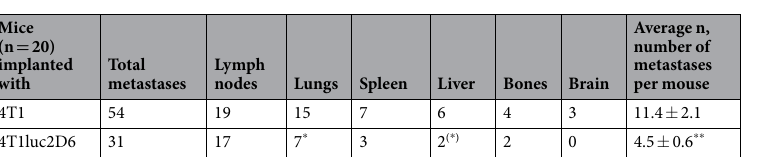
Fig. 7A,B). Luc-specific IFN- γ response was detected in both 4T1luc2D6- and in 4T1luc2-, but not in naïve, or 4T1-implanted mice (Fig. 7A). We followed the development of this response in mice implanted with 4T1luc2 cells in time. Lymphocytes were collected prior to and post 4T1luc2 implantation on days 6, 9 (PBMCs) and 23 (splenocytes), and stimulated with LucP. A weak LucP-specific production of IFN- γ first detected on day 9 post implantation, increased to significant levels by day 23 (Fig. 7B). Interestingly, induction of the response coincided with a decrease in the growth rate of the primary focus formed by 4T1luc2 cells (Fig. 2A). Immune response against luciferase induced by DNA immunization protects against the estab - lishment of 4T1luc2 tumors. To further test whether a Luc-specific immune response can limit tumor invasiveness, we primed and then boosted mice with a plasmid (pVaxLuc, dubbed Luc DNA) encoding the same variant of firefly luciferase as is expressed by 4T1luc2 and 4T1lucD6 cells. Control mice received an empty vector (pVax1). Plasmids were delivered by intradermal injections. Immediately after, mice were electroporated over the injection sites using DermaVax (Cellectis) generating driving pulses of 100 V (as described) 22 (n = 4) or CUY21 EditII (BEX Ltd.) generating driving pulses of 100 V (n = 6), or 50 V (n = 4).